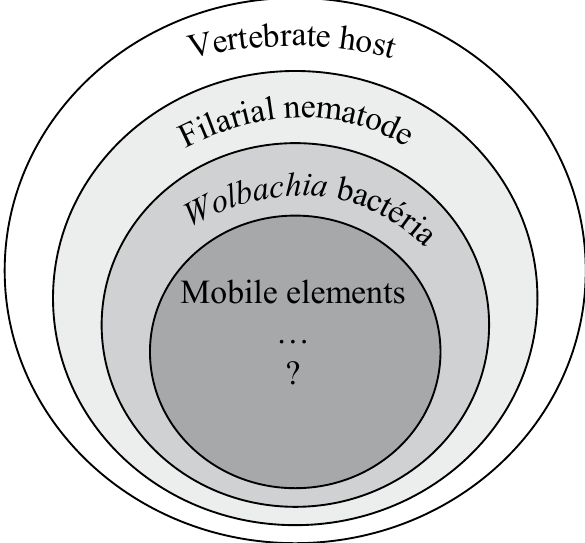
Fig. 4. – the multipartite association between Wolbachia , filarial nematode and the vertebrate host. taking in account all the partners involved in the relationship between the bacteria and filariae increased the complexity of the symbiosis. the bacteria can host mobile genetic elements and the filariae are parasites of